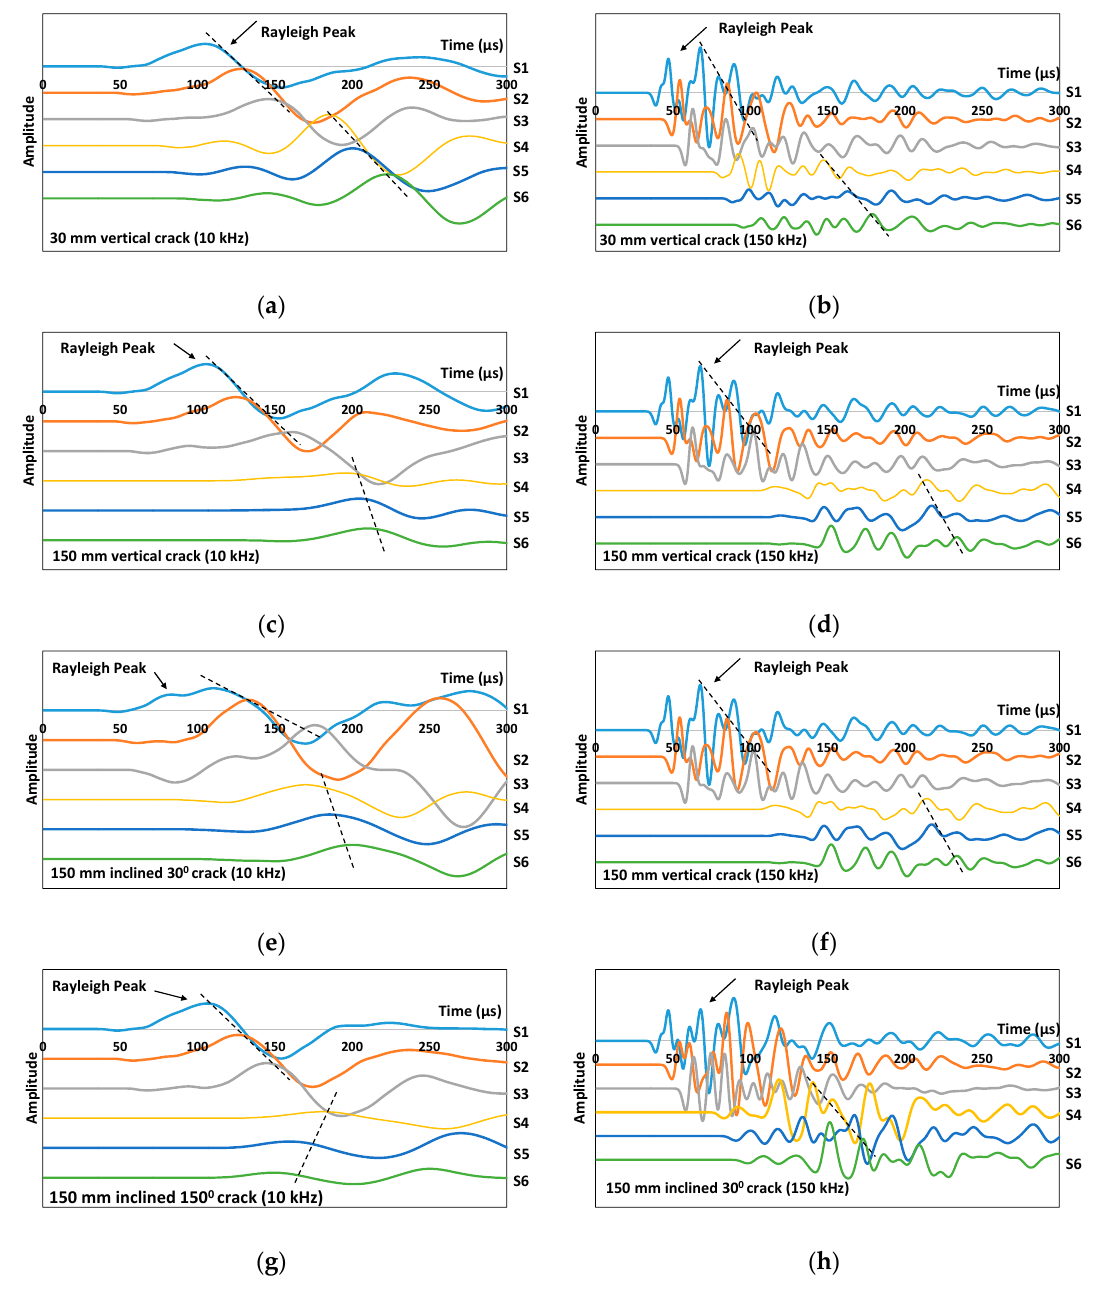
Figure 3. Simulated waveforms collected for 30 mm vertical (90°) crack model using ( a ) 10 kHz and ( b ) 150 kHz excitations; for 150 mm vertical (90°) crack model using ( c ) 10 kHz and ( d ) 150 kHz excitations; for 150 mm inclined 30° crack model using ( e ) 10 kHz and ( f ) 150 kHz excitations; for 150 mm inclined 150° crack model using ( g ) 10 kHz and ( h ) 150 kHz excitations. Waveform data recorded from sensors S3 (left hand size of crack) and S4 (right hand side of crack) at excitation frequency of 30 kHz is depicted in Figure 4, for the vertical crack (90°) and the one inclining at 150°. For the vertical crack, waveforms obtained from the sensor on the left hand side of the crack did not exhibit much difference in terms of amplitude and R-wave arrival time.